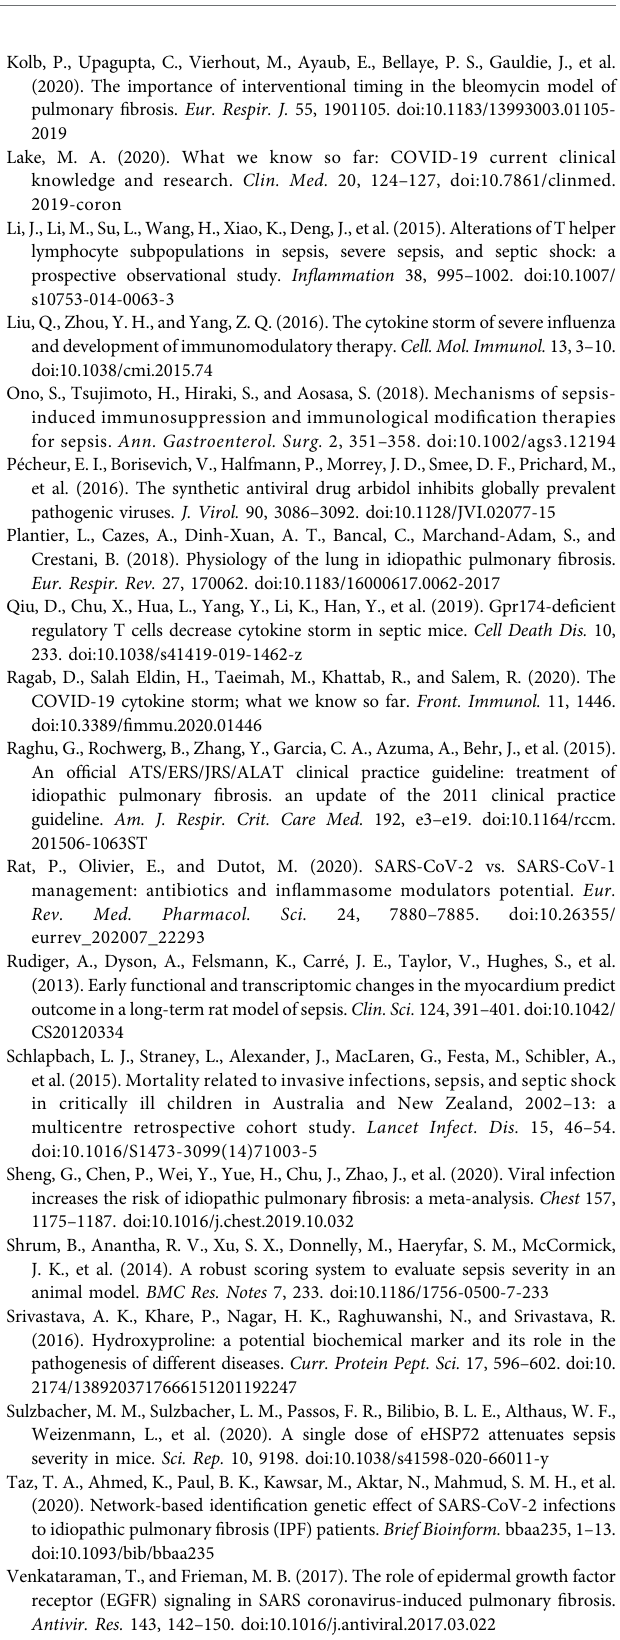
Frontiers in Pharmacology |